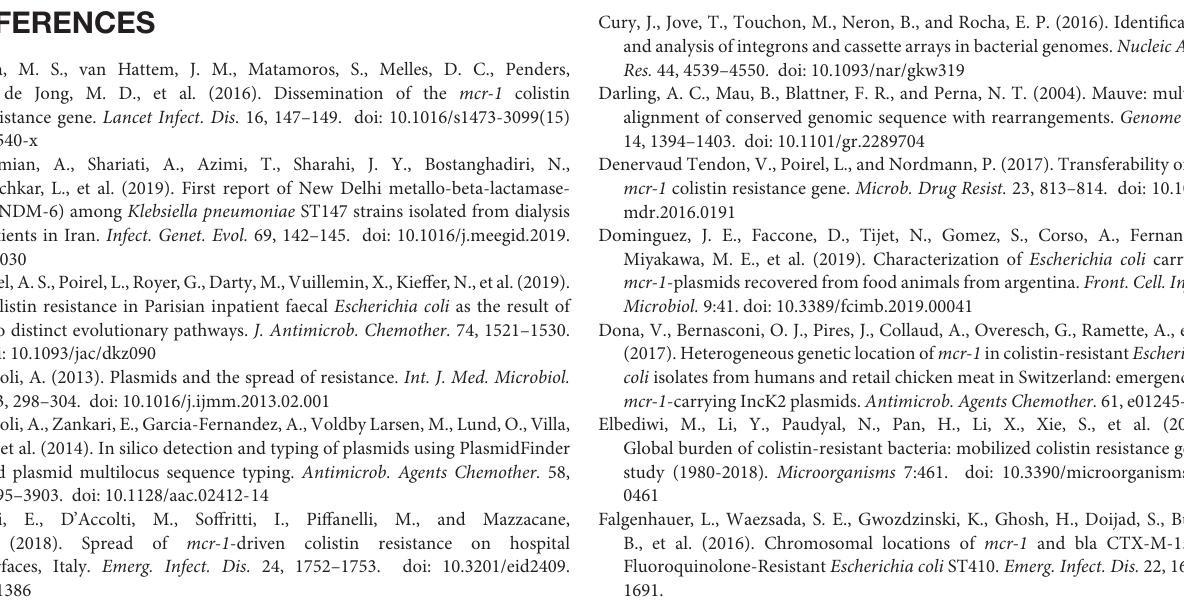
Supplementary Table 1 | Overview of non-mcr -1 plasmids including size and Inc types. Supplementary Table 2 | Table showing mcr-1 plasmids that contained additional antibiotic resistance genes and the corresponding antibiotic classes.